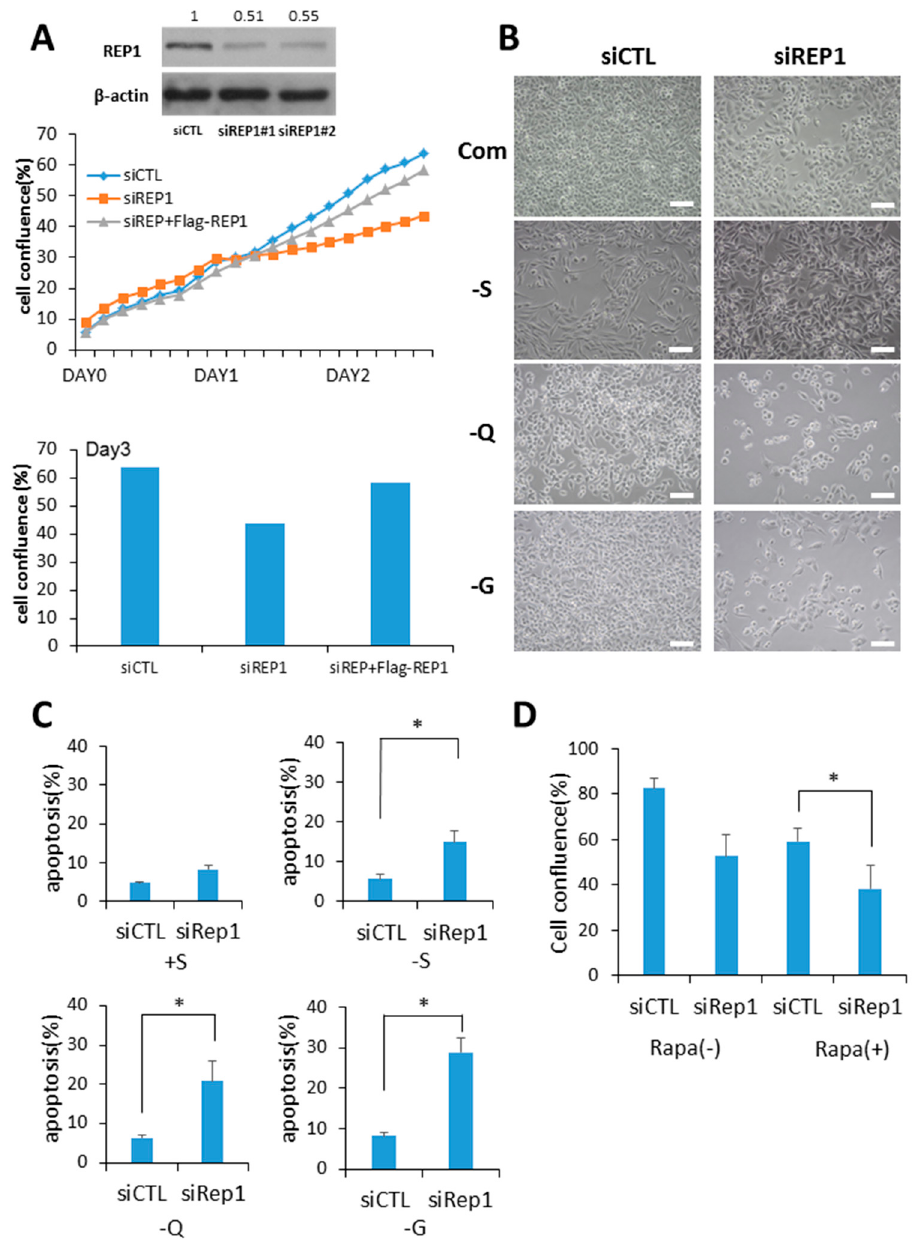
Figure 1. Rab escort protein1 (REP1) depletion suppresses cell growth and survival. ( A ) MiaPaCa2 cells were transfected with control (CTL) and REP1 small interfering RNAs (siRNAs). After 48 h, immunoblotting was performed to analyze REP1 protein levels. Cells were treated with CTL and REP1 siRNAs and incubated for 24 h. Then, the cells were transfected with Flag-REP1 plasmid additionally and further incubated in the IncuCyte TM for monitoring cell proliferation. At the 72-h incubation time point, cell confluence levels were presented as a percentage using the IncuCyte TM analyzer. ( B , C ) MiaPaCa2 cells were transfected with control and REP1siRNAs, which replaced the following day with serum-, glucose-, or glutamine-free medium and then incubated for another 24 h.Cell morphology was observed by brightfield image. Scale bar: 50 μ m ( B ). Cell death was assessed by using the Annexin V/propidium iodide (PI) assay ( C ). Error bars indicate mean +/ − standard error for n = 3 independent experiments. ( D ) MiaPaCa2 cells were transfected with control (CTL) or REP1siRNAs, which replaced the following day with 1 μ M rapamycin and then further incubated for monitoring cell confluence using IncuCyte TM . At 72 h time point, cell confluence levels were presented as percentage. Statistical significance was determined via t-test; * p < 0.05.